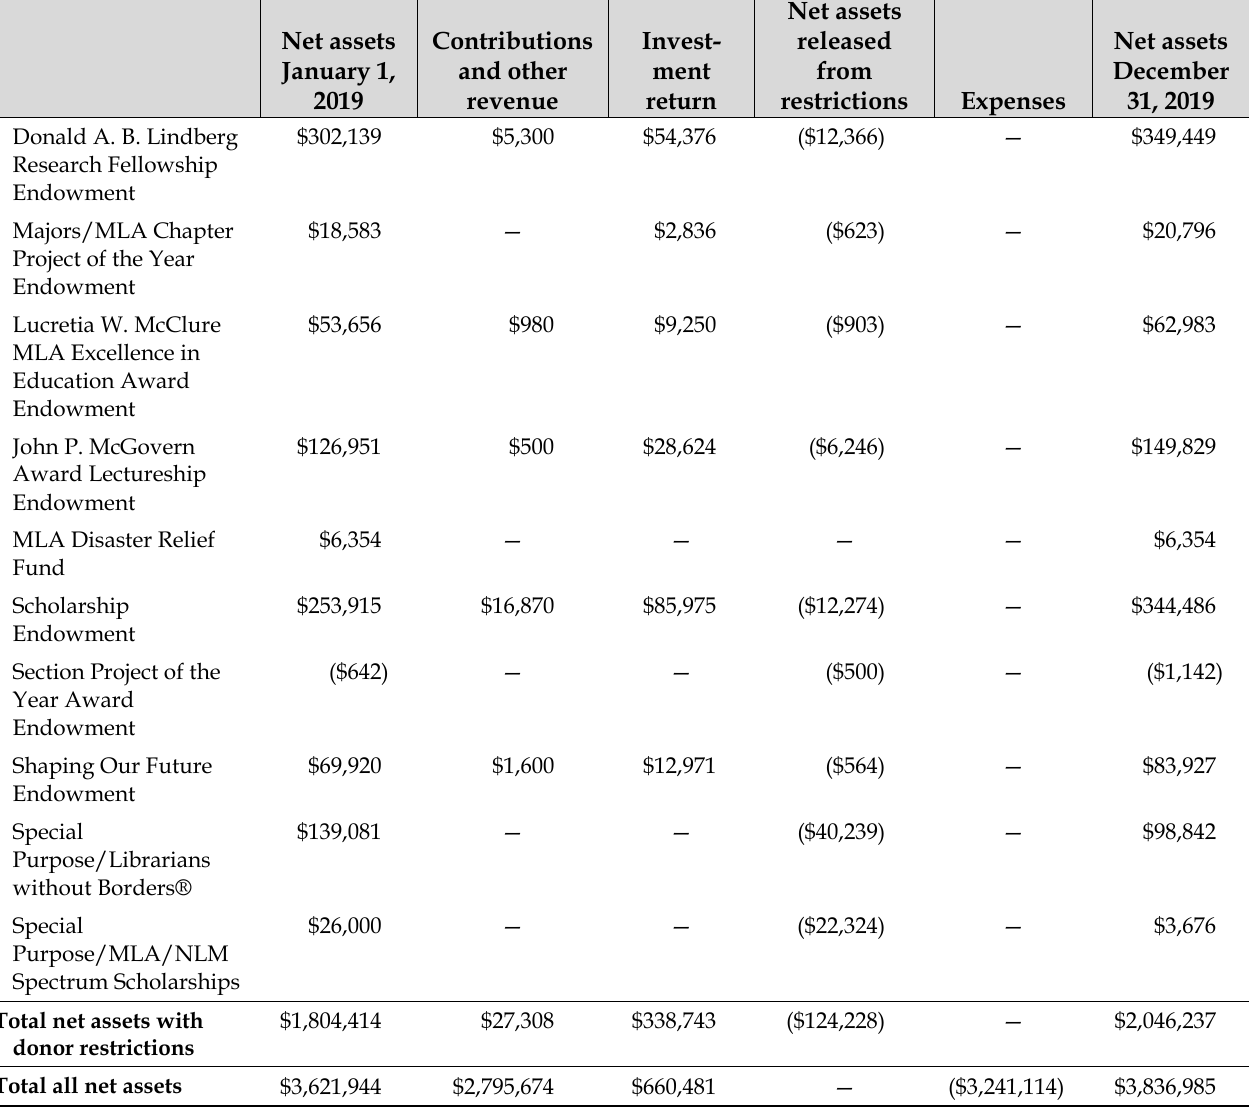
Table 1 Medical Library Association schedule of changes in net assets by fund year ended December 31,